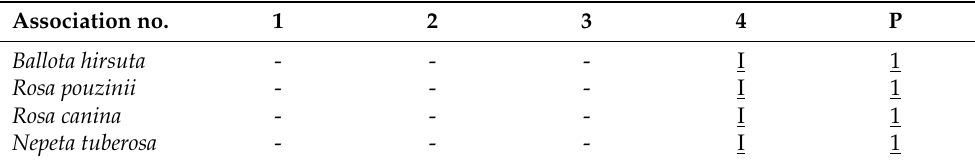
Other taxa —Companions: Selaginella denticulata (P-2), Genista hirsuta (P-1), Clinopodium arundanum (P- 2), Lonicera periclymenum subsp. hispanica (P-1), Carlina corymbosa (P-1), Hyparrhenia sinaica (P-2) I in